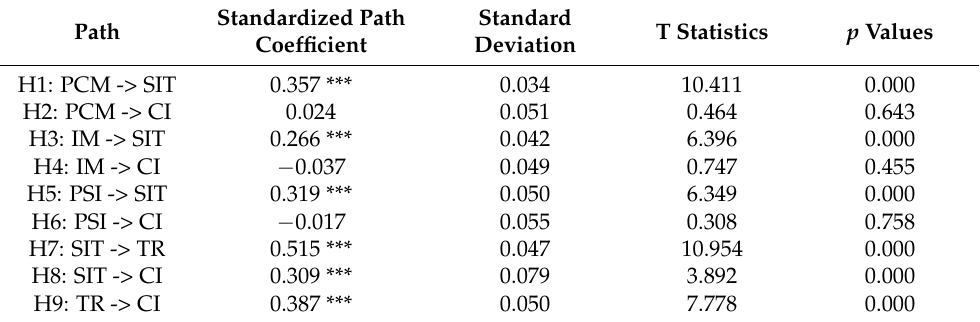
Table 6. Path coefficients and its